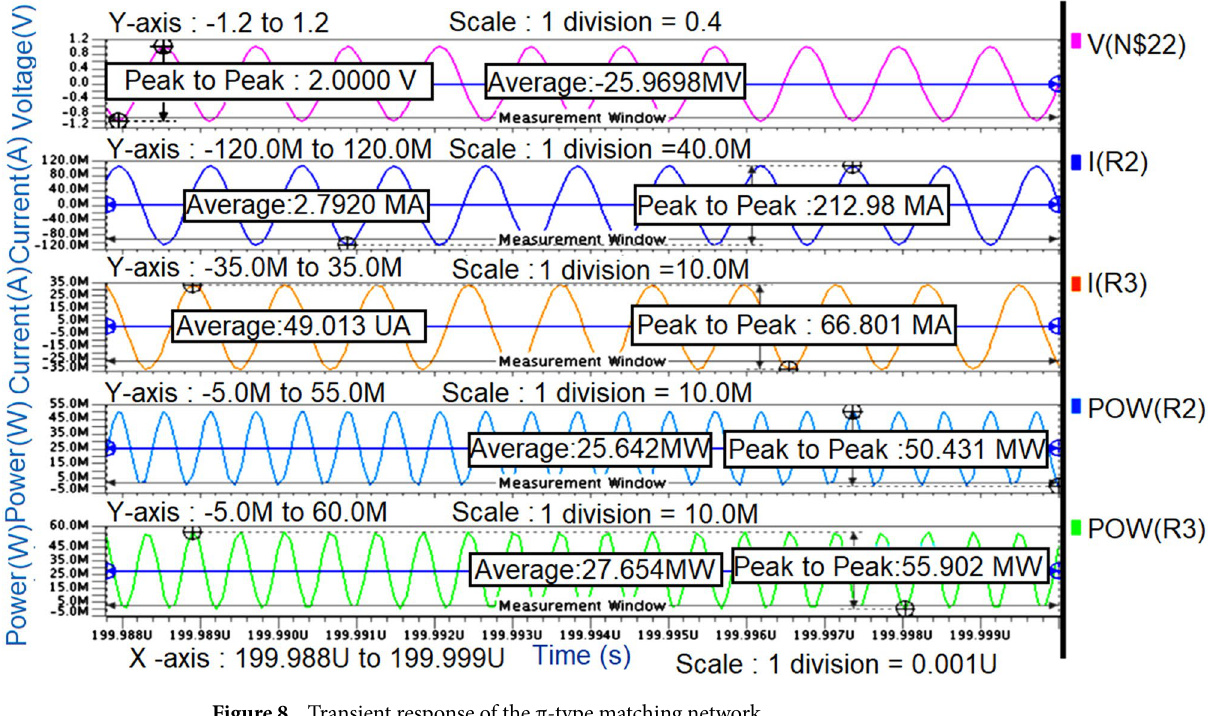
Figure 8. Transient response of the π-type matching network.